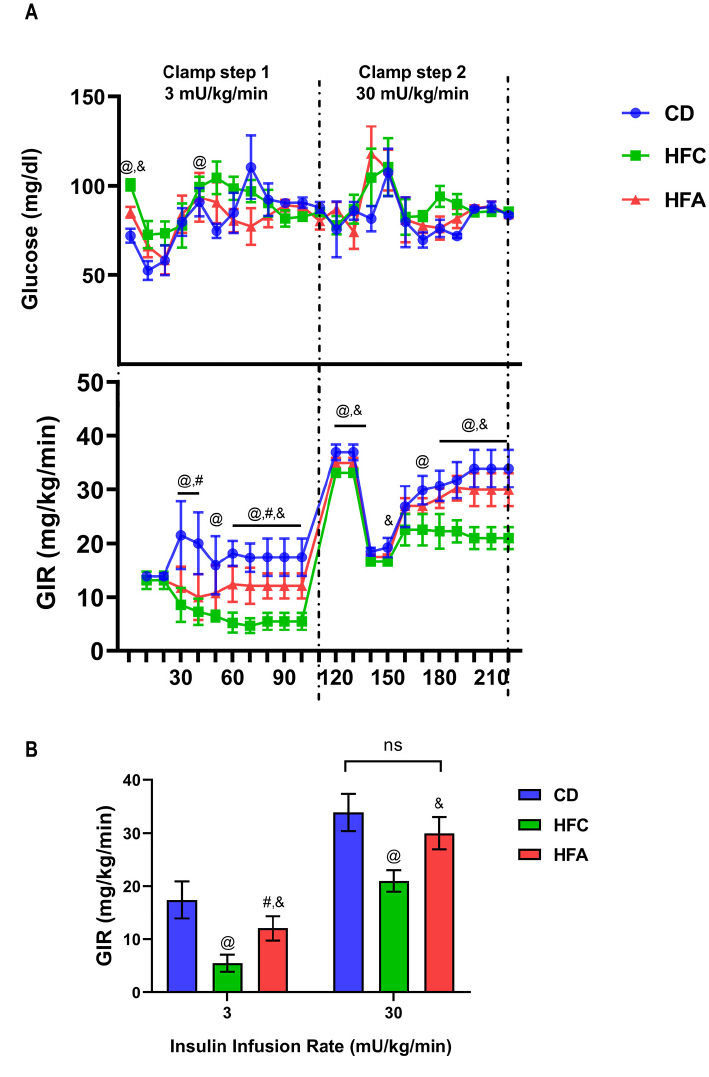
Figure 3. Changes in blood glucose level and glucose infusion rate (GIR) in the hyperinsulinemic– euglycemic clamp test: ( A ) The time course of glucose concentration and GIR. Low-dose insulin (3 mU/kg) was continuously infused during step 1 and high-dose insulin (30 mU/kg) during step 2; ( B ) differences in GIR at low and high insulin doses. Results are expressed as mean ± SD; n = 6 per group. @: CD vs. HFC, #: CD vs. HFA, &: HFC vs. HFA, p < 0.05; and ns, no significant difference.